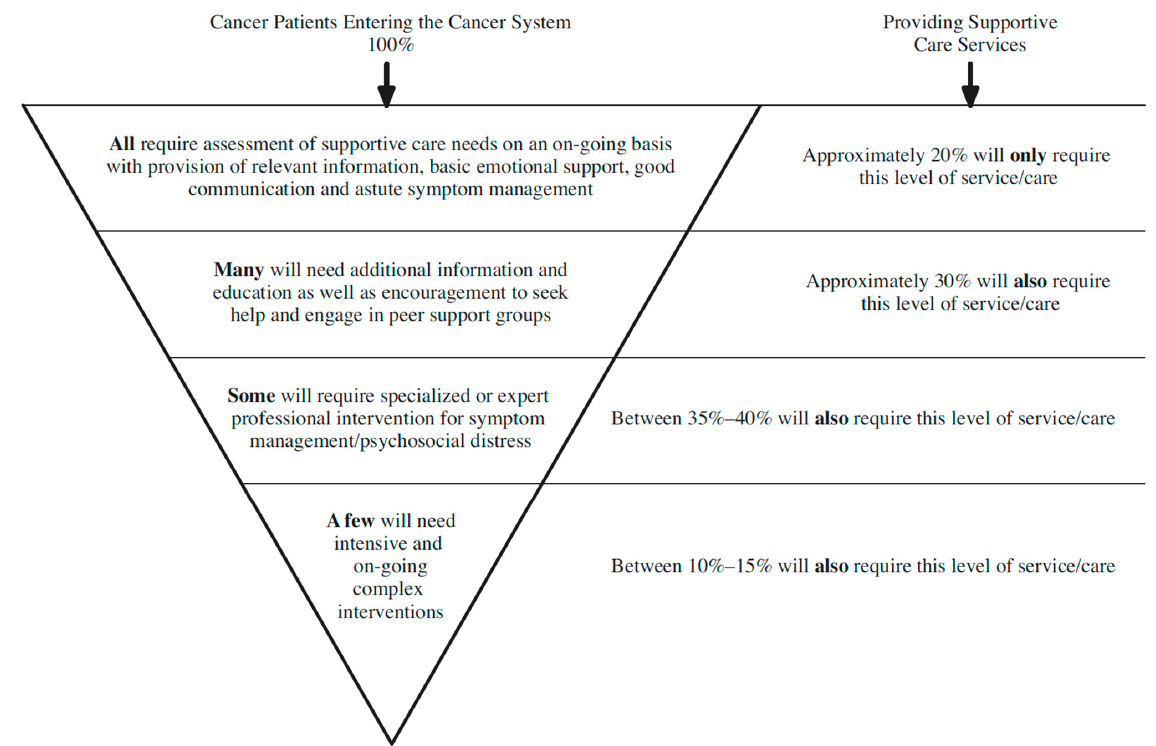
Figure 1. Psychosocial oncology services and estimated proportions of patients requiring each level of care [33] (p. 12, figure reprinted with permission from the Canadian Oncology Nursing Journal ).